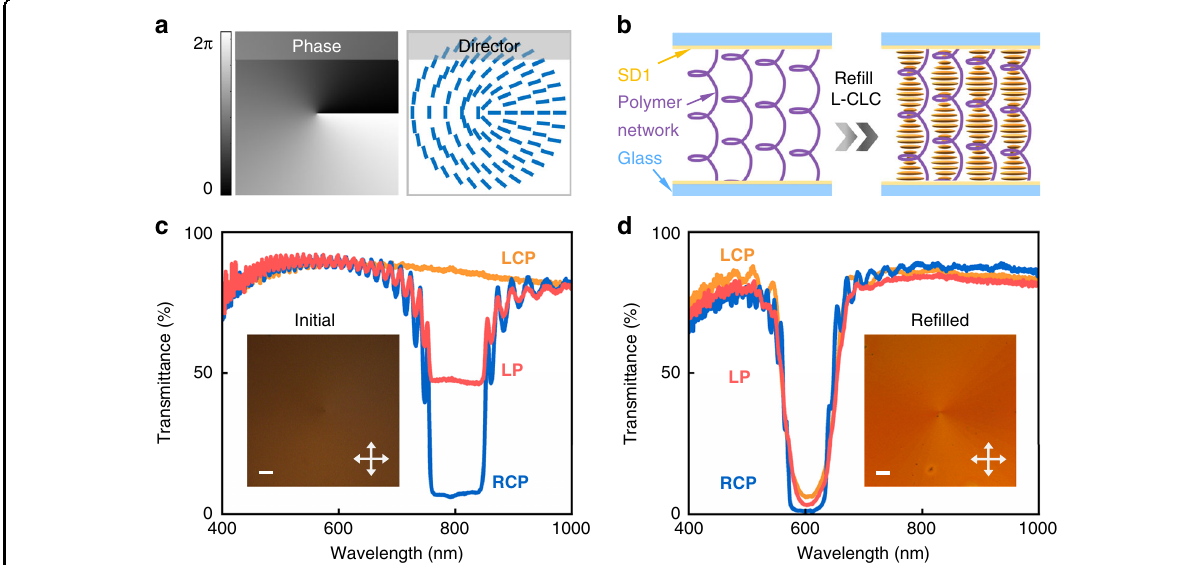
Fig. 2 The designed pattern, re fi lling process, and transmittance spectra of opposite-chirality-coexisted superstructures for spin- dependent OVs. a Spiral phase pattern with q = + 0.5 and corresponding surface LC director distribution. The color variation from black to white denotes the phase varying from 0 to 2 π . The short blue stick indicates the local LC director on the initial side of CLC helixes. b Schematic illustration of the washed-out state (left) and the re fi lled state (right) of the fabrication process of opposite-chirality-coexisted superstructures. c , d The transmittance spectra of the initial state and the re fi lled state under different incident polarization of LCP (orange), LP (pink), and RCP (blue), respectively. Inserts are corresponding re fl ective micrographs observed under a polarized optical microscope. Crossed white arrows represent the orthogonal polarizer and analyzer. All scale bars are 100 μ